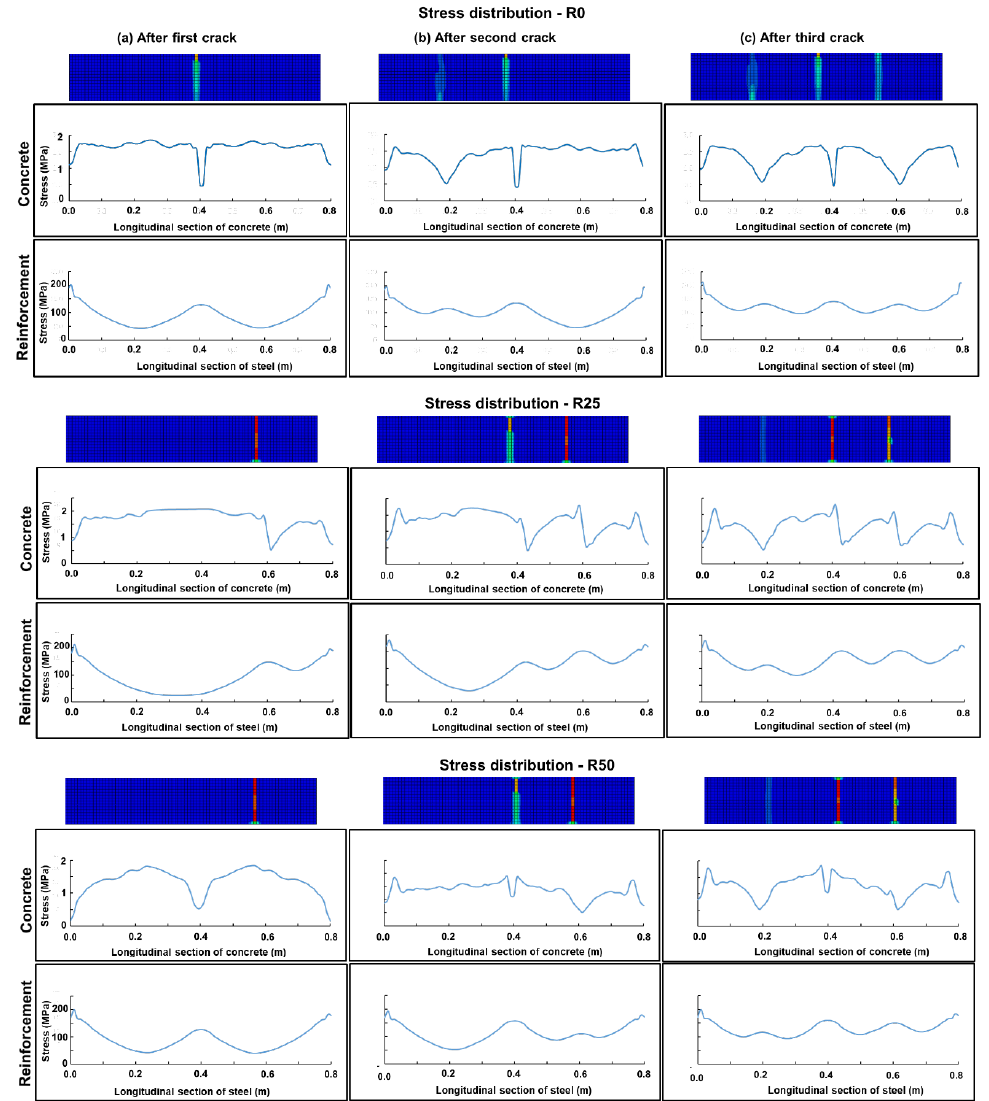
Figure 15. Stress distribution in concrete and in reinforcement along the elements after: a) first crack; b) second crack and c) third